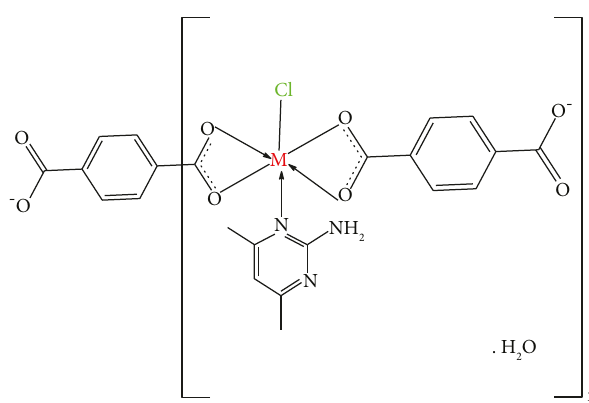
Figure 6: Suggesting structure of Cr(III) and V(III) coordination polymers (M � Cr or V).